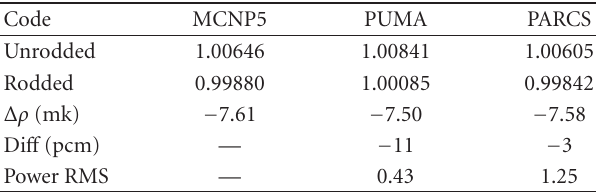
Table 8: CNA-I idealized core—hafnium